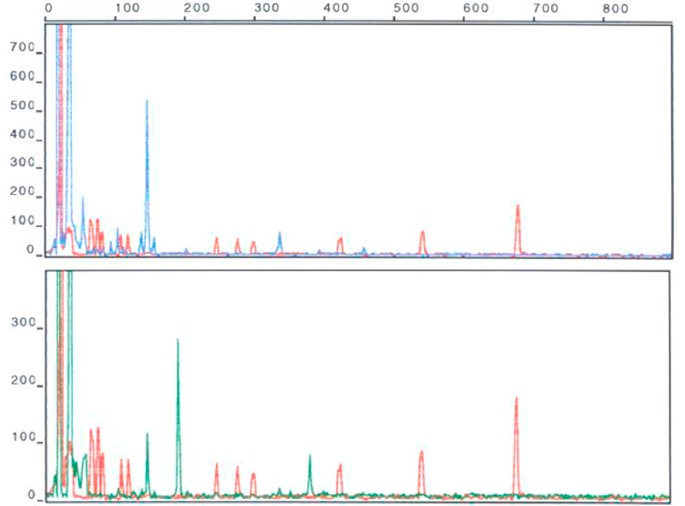
Figure 24. An example of actinobacterial 16S fingerprinting. Forward and reverse Terminal Restriction Fragment Length Polymorphism (T-RFLP) from a Sanger sequencer for a Russian taiga forest soil (Rusforest-Yenisei). PCR products of 16S actinobacterial specific primers were labelled with the dyes hexachloro-6-carboxyfluorescein (blue, forward) and carboxyfluorescein (green, reverse). Red peaks are the ROX 1000 size standards. Size is shown on the X axis in bp, fluorescence on the Y axis. The size range 81–677 bp was used for clustering analysis of forward T-RFLP patterns from a range of samples (shown in Figure 4).